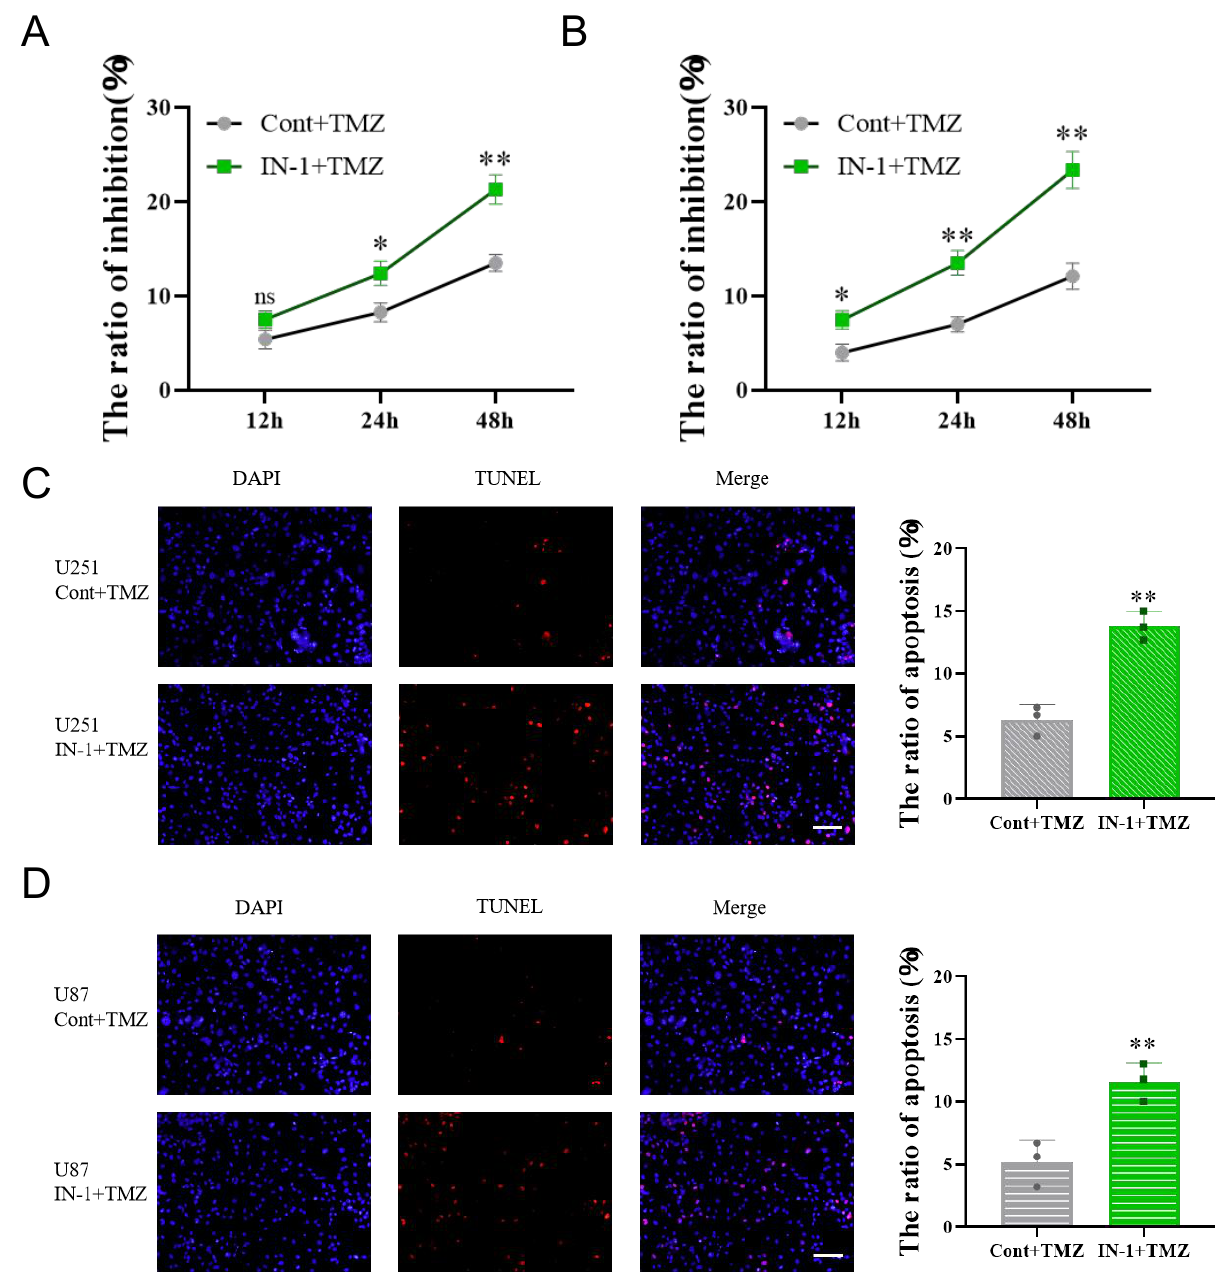
Figure 8. Analysis of the oil content in rapeseed, the residual oil content in rapeseed cake and the oil yield in oil processing with/without microwave pretreatment of rapeseed. Values are the means standard deviations; n = 3 parallel determinations. a–c Mean values (a > b > c, corresponding ± apoptosis of U251 and U87 cells.* p < 0.05, ** p < 0.01, ns: p > to the same parameter) not followed by a common letter differ significantly ( p < 0.05).